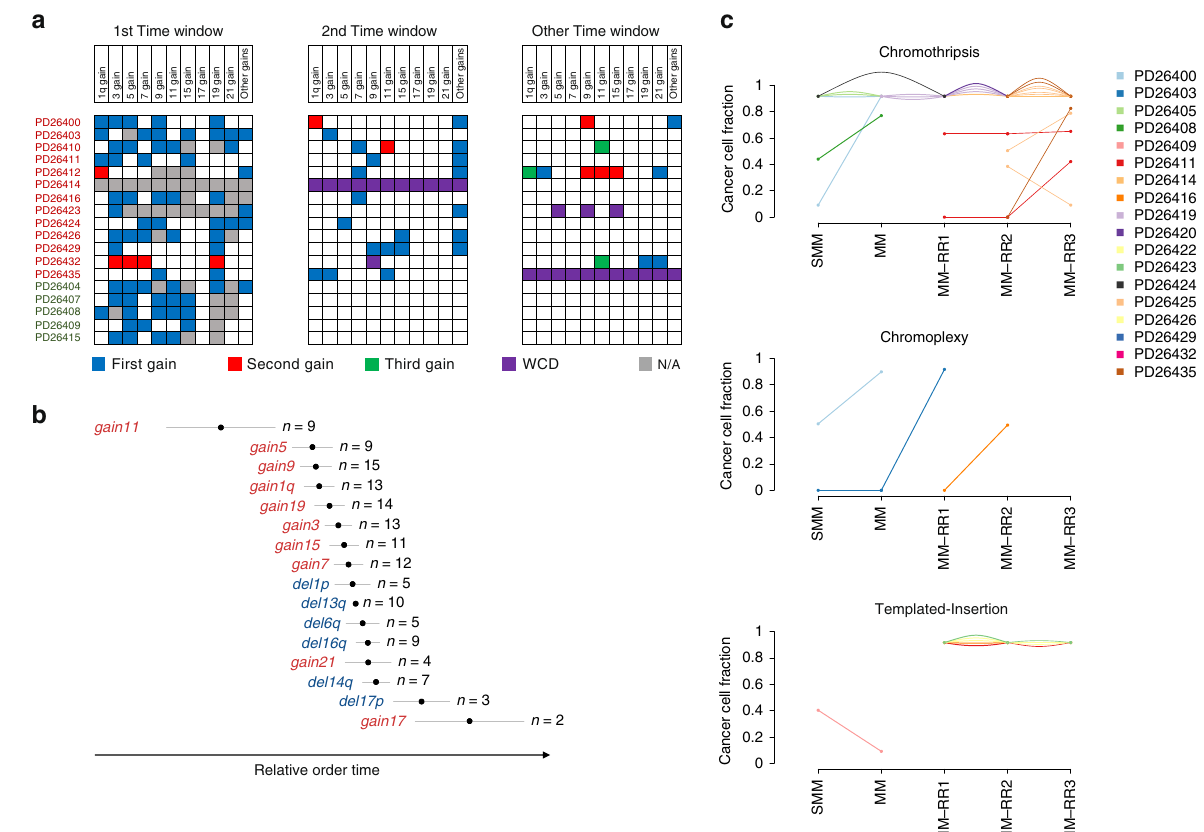
Fig. 4 The chronological reconstruction of aneuploidies acquisition in MM. a Heatmaps representing the cumulative acquisition of copy-number gains observed in 13/18 hyperdiploid patients, labeled in red if the fi nal HRD pro fi le was generated by multiple and independent events ( n = 13) or green if the trisomies were acquired in one single time window ( n = 5). Boxes are color-coded based on the relative order of acquisition of each event; WCD = whole chromosome duplication. b A Bradley – Terry model based on the integration between the CCF and molecular time of each recurrent CNAs (gains = red and deletions = blue) for all 30 MM cases included in this study. Segments were ordered from the earliest (top) to the latest (bottom) occurring in relative time from sampling. The time scale ( X -axis) is relative since timing of genomic evolution is variable from case to case and not easily correlated to